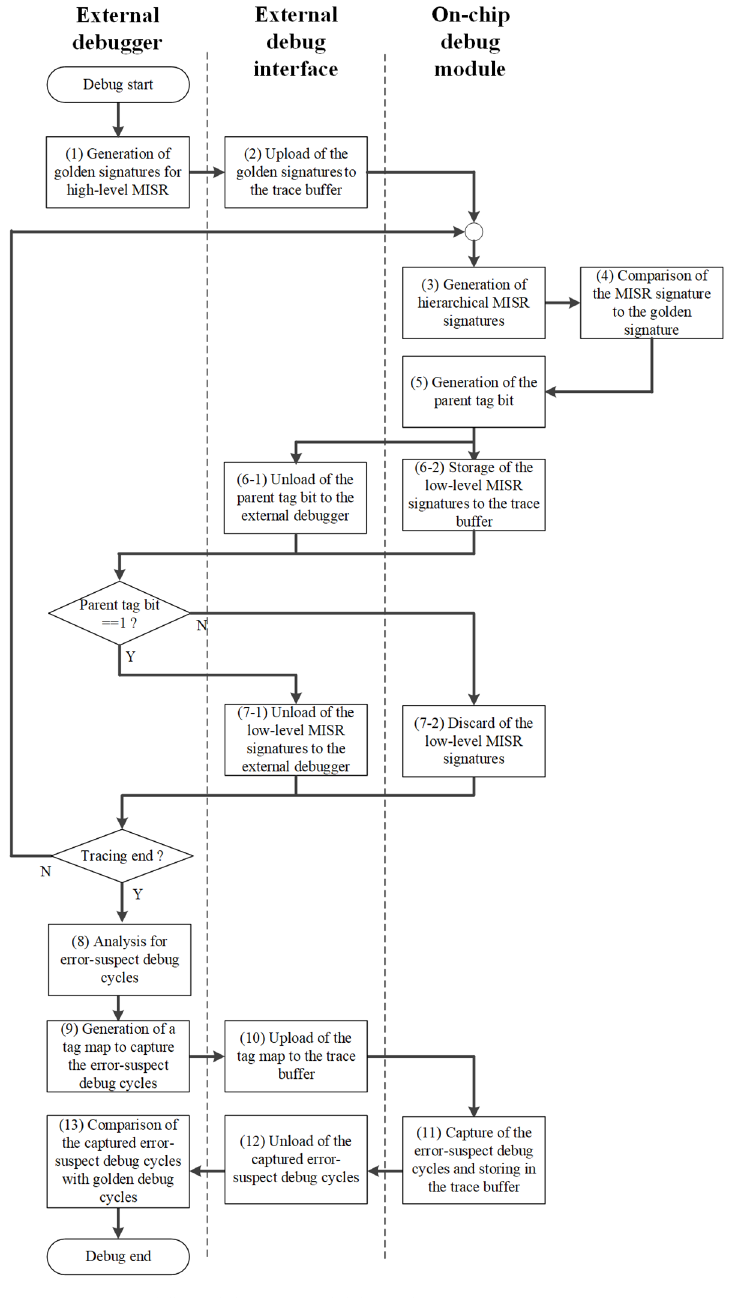
Fig 2. Operational flow of the proposed debug